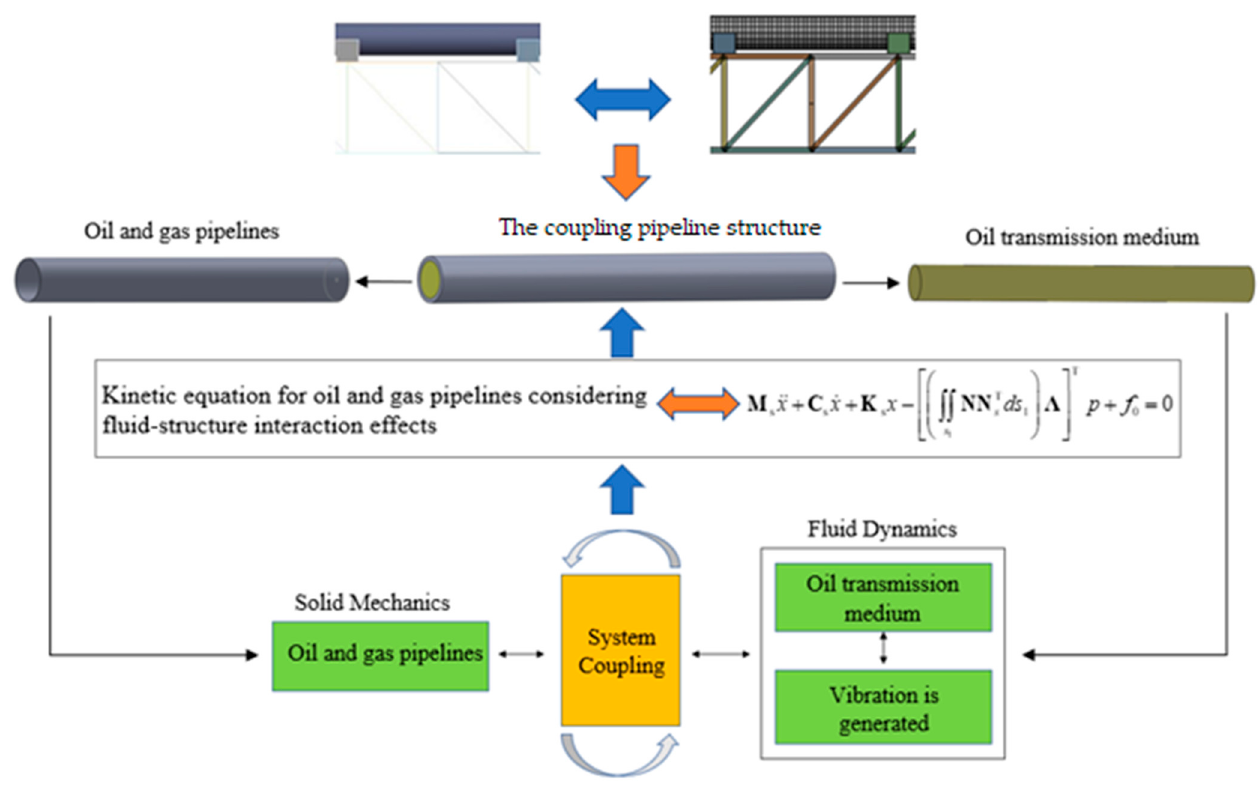
Figure 4. Flow-solid coupling dynamics analysis of oil and gas transmission pipeline.